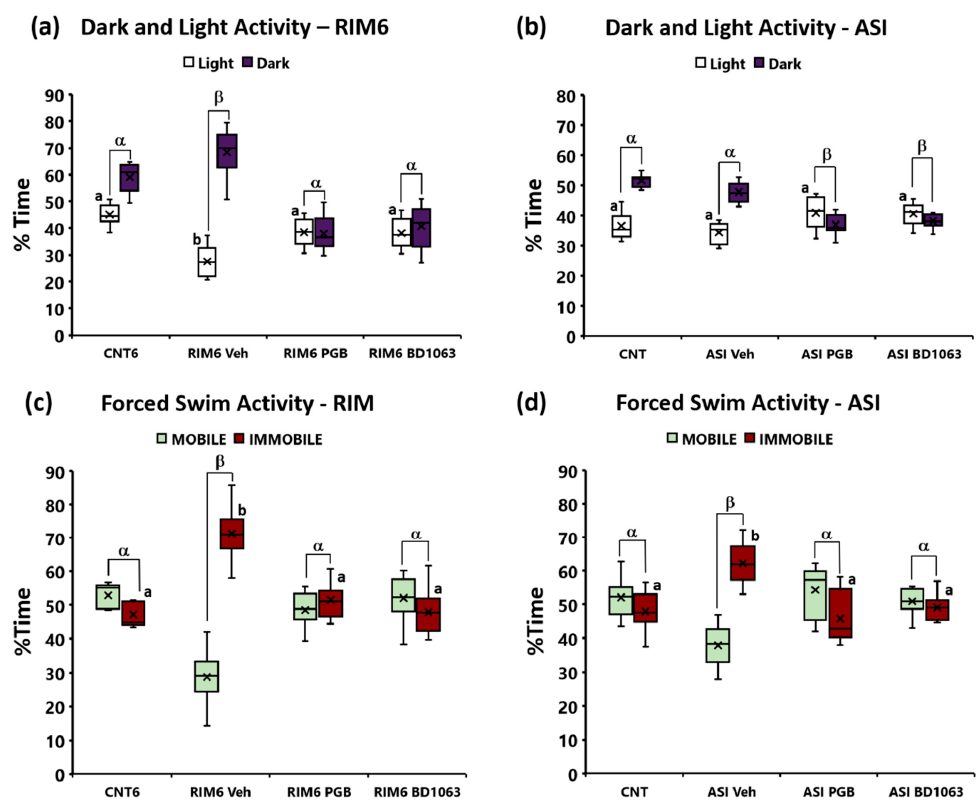
Figure 4. Nonreflexive pain responses in both experimental models of fibromyalgia in animals treated with pregabalin and BD1063. ( a , b ) Results of the light/dark box test assessing anxiety-like behavior in both experimental models of fibromyalgia. a,b: Groups not sharing a letter are significantly different in time spent in the light zone, p < 0.05. α , β : Groups not sharing a letter are significantly different in time spent in the light zone—time spent in the dark zone, p < 0.05. ( c , d ) Results of the forced swimming test assessing depression-like behavior in both experimental models of fibromyalgia. a,b: Groups not sharing a letter showed significant differences in %Immobility time, p < 0.05. α , β : Groups not sharing a letter showed significant differences in %Immobility–%Mobility time, p < 0.05. In all cases, data are expressed as the median ± IQR, and the mean is shown as